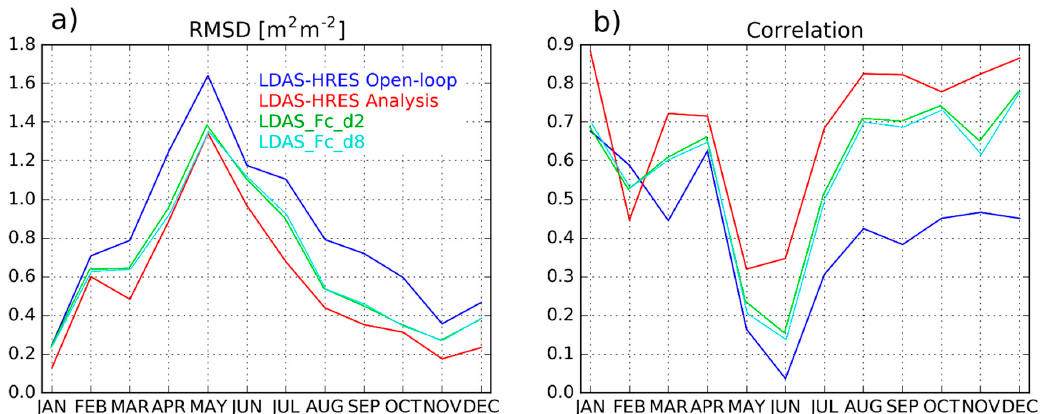
Figure 10. Monthly ( a ) RMSD and ( b ) R values between LAI from the model (LDAS-HRES open-loop in blue), analysis (LDAS-HRES Analysis in red), the 2-d and 8-d forecast experiments initialized by the analysis and the Copernicus Global Land Service LAI GEOV2 over